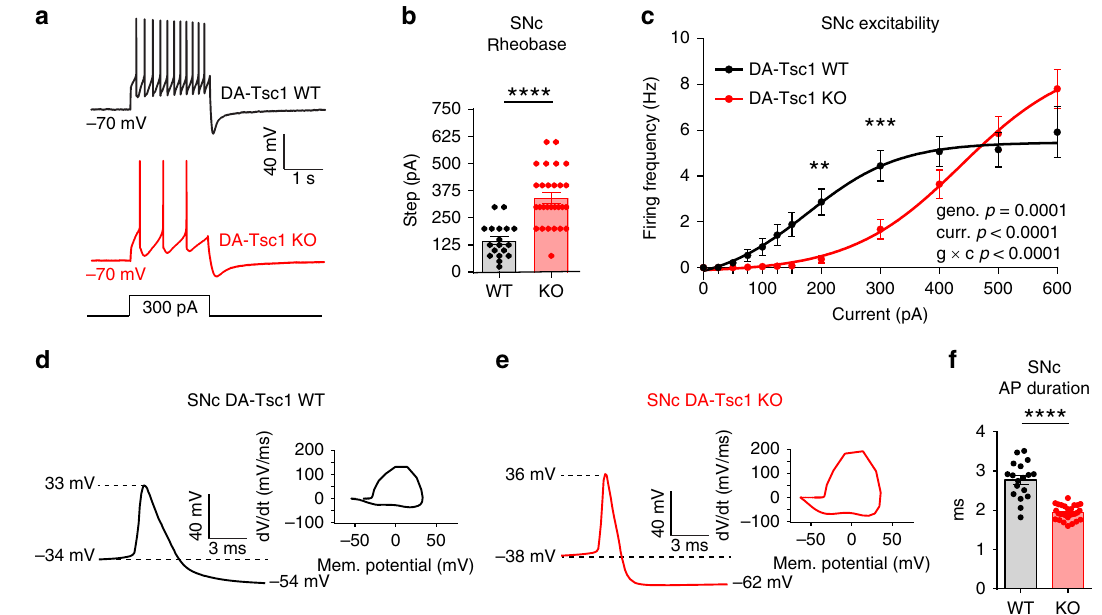
Fig. 2 DA-Tsc1-KO SNc neurons are hypoexcitable. a Examples of action potential fi ring elicited with a 300 pA current step in SNc DA neurons. b Mean ± SEM rheobase of SNc DA neurons calculated as the current at which action potentials were fi rst elicited (DA-Tsc1 WT: n = 18 neurons from fi ve mice, DA- Tsc1 KO: n = 28 neurons from nine mice). **** p < 0.0001, Welch ’ s two-tailed t test. c Excitability curves showing the fi ring frequency of SNc DA neurons in response to current steps of increasing amplitude. Data are displayed as mean ± SEM (DA-Tsc1 WT: n = 20 neurons from fi ve mice, DA-Tsc1 KO: n = 32 neurons from nine mice). Two-way ANOVA p values are shown. ** p = 0.0014; *** p = 0.0002, Sidak ’ s multiple comparisons test. d , e Examples of individual action potentials evoked by positive current injection and their respective phase plots for SNc DA neurons in DA-Tsc1-WT ( d ) and DA-Tsc1-KO ( e ) mice. f Mean± SEM action potential (AP) duration of SNc DA neurons (DA-Tsc1 WT: n = 18 neurons from fi ve mice, DA-Tsc1-KO: n = 28 neurons from nine mice). **** p < 0.0001, Welch ’ s two-tailed t test. For all bar graphs, dots represent values for individual neurons. See also Supplementary Fig. 1 and Supplementary Tables 1 and 2. Source data are provided as a Source Data fi Fig. 2e). Notably, the dorsal striatal release de fi cits in DA-Tsc1-